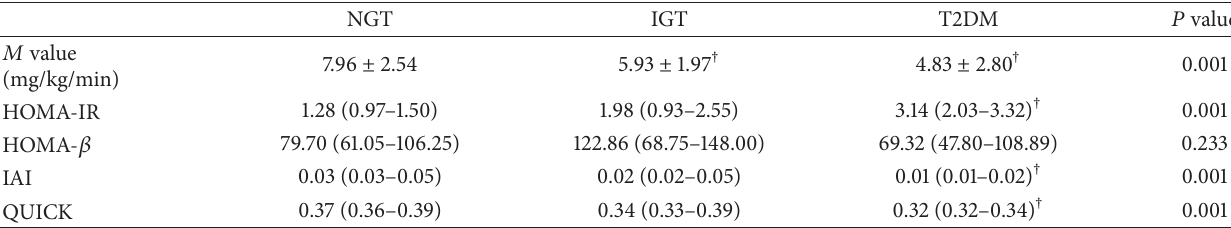
Table 2: Insulin sensitivity and